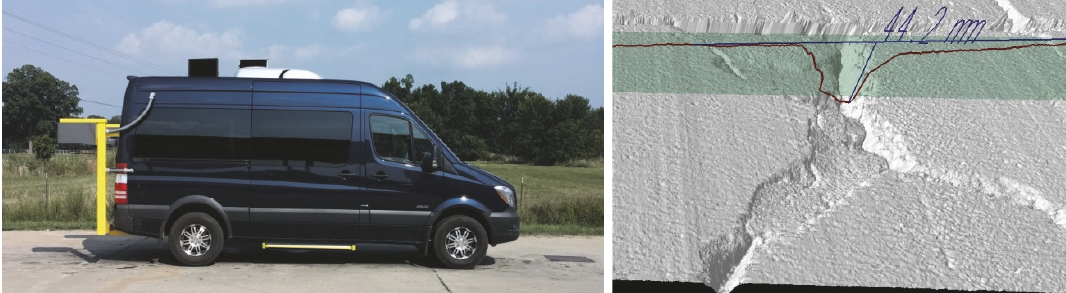
Figure 2: PaveVision3D Ultra System (left) and representative 3D pavement data